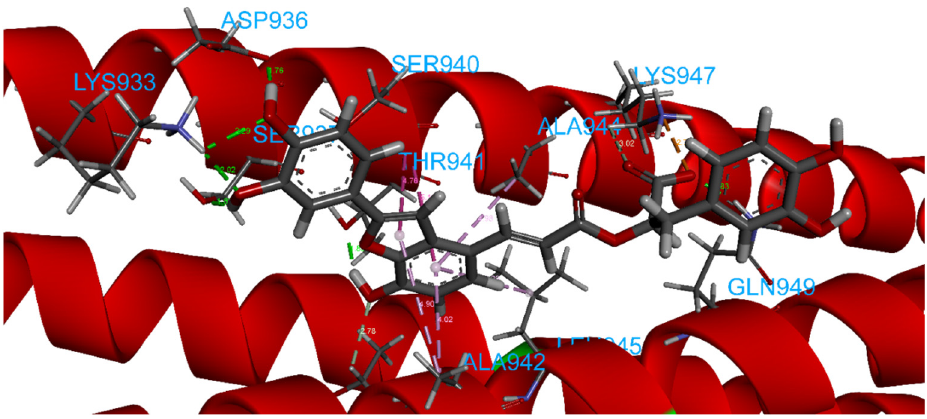
Figure 12. Details of calculated 3D interactions of Sal C in complex with SARS-CoV-2’s HR1 domain. The binding energy of the complex stabilizes after 0.2 ns of the MD simulation and maintains overall stability for the rest of 20 ns